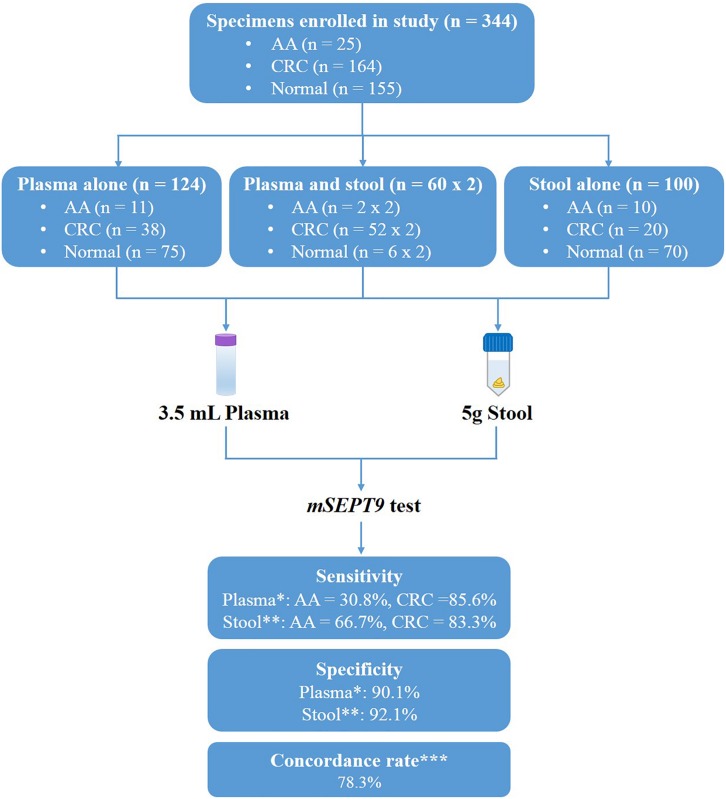
Study design and diagnostic accuracy measures obtained with methylated SEPT9 test on plasma and stool samples. ∗Data analyzed by 1/3 algorithm. ∗∗Data analyzed by 3/3 algorithm with the mean Cp value of methylated SEPT9 less than 40.0. ∗∗∗Concordance rate was calculated from the 42 paired plasma and stool samples.